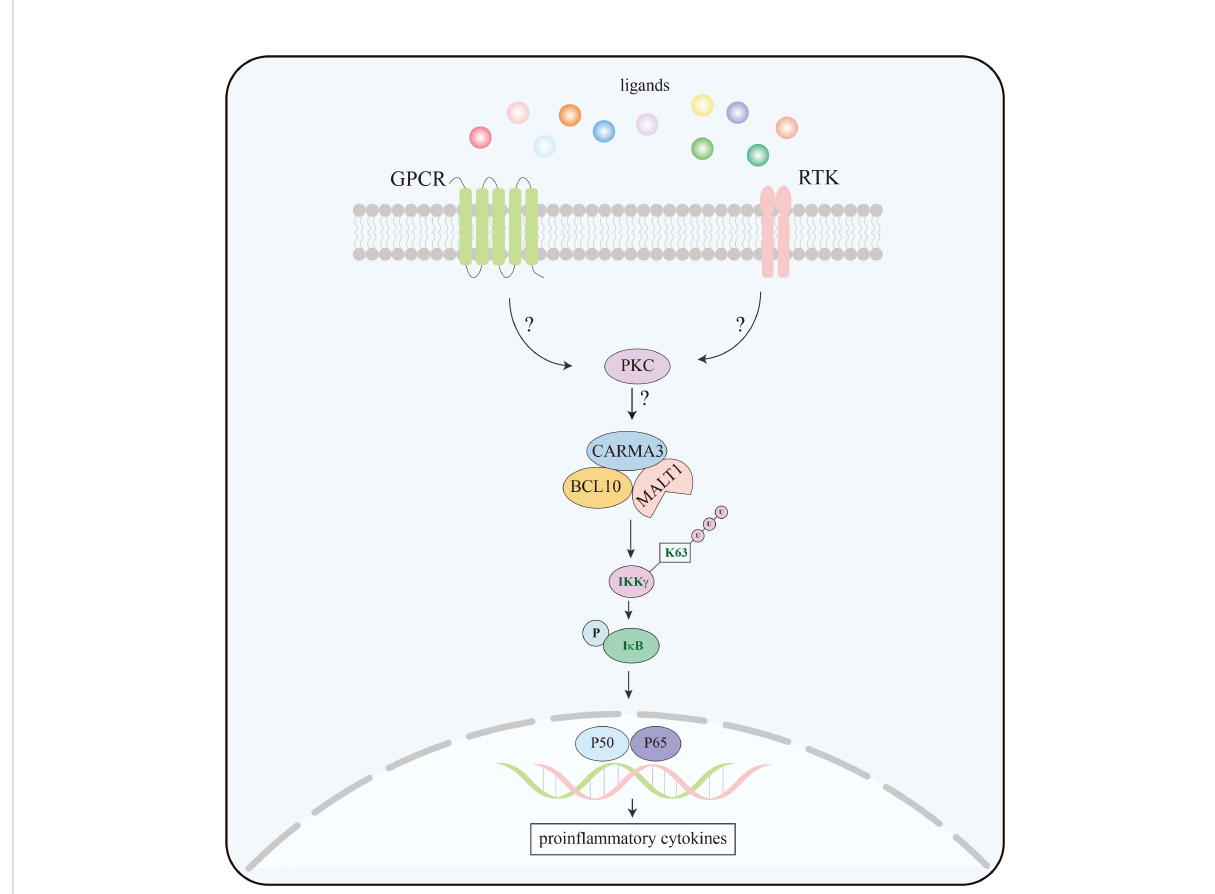
FIGURE 2 Schematic overview of GPCR/RTK-CARMA3 signaling pathway leading to NF- k B activation. GPCRs and RTKs bind the ligands and activate the downstream signaling pathway. Upon activation, CARMA3 forms a complex with BCL10 and MALT1, resulting in K63-linked ubiquitination of IKK g . This event activates IKK complex, which triggers NF- k B activation by phosphorylation of I k